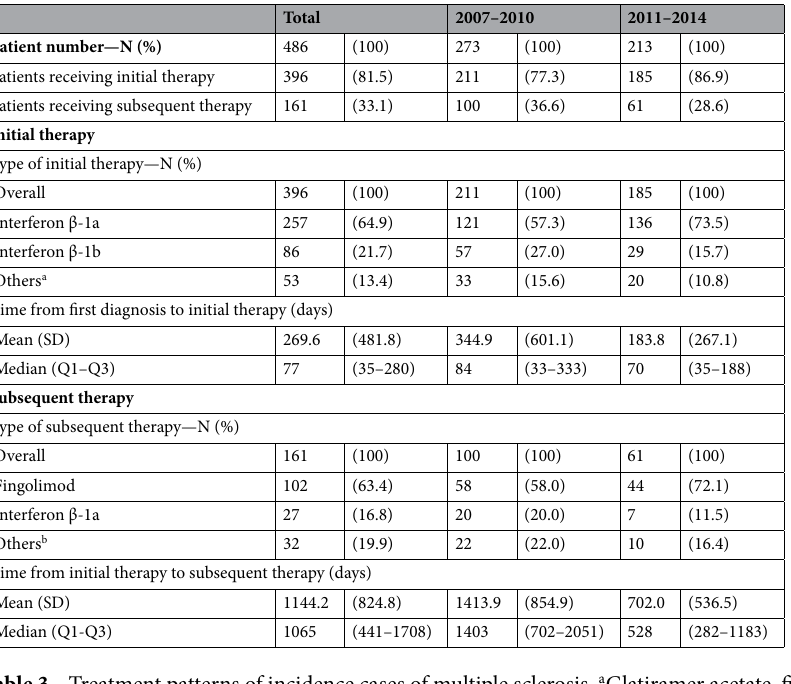
Table 3. Treatment patterns of incidence cases of multiple sclerosis. a Glatiramer acetate, fingolimod and azathioprine. b Natalizumab, glatiramer acetate, interferon β-1b, azathioprine, mycophenolate mofetil, mitoxantrone and